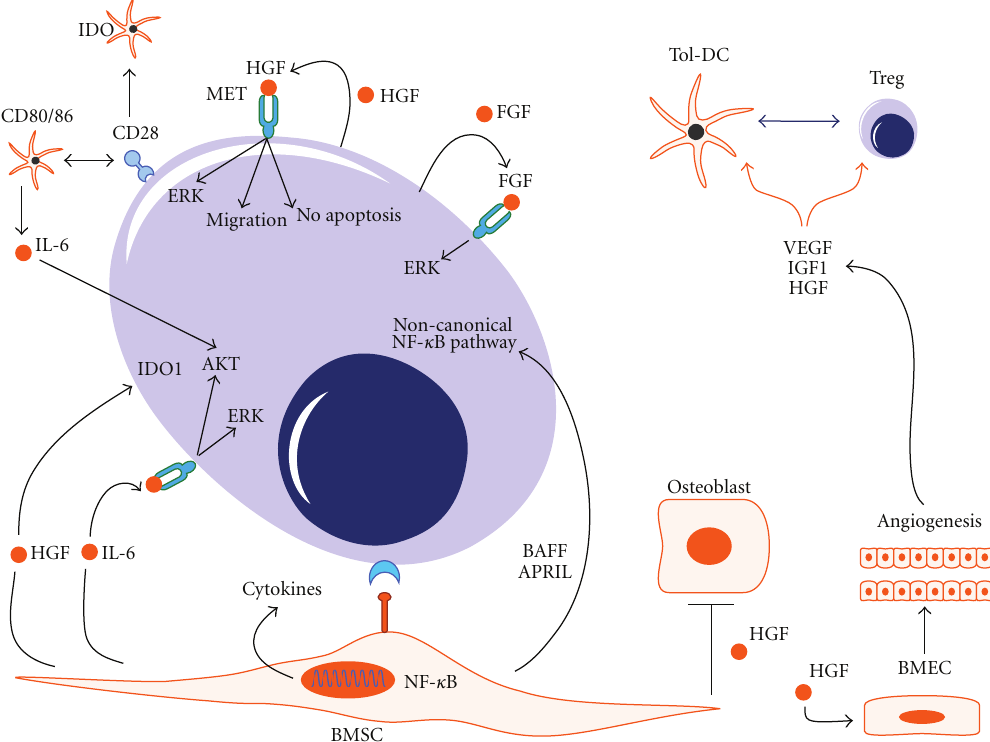
Figure 1: Interactions between myeloma and microenvironmental cell types. It is widely accepted that the BM microenvironment promotes myeloma growth [23]. Several cytokines can be released upon the interaction of MM plasma cells and BM microenvironmental cells, such as BM stromal cells (BMSCs), BM endothelial cells (BMECs), and osteoblasts. Among them, HGF is an attractive target for therapy, given its undisputed role in disease pathogenesis and its potential contribution to the myeloma-induced immune dysfunction through the upregulation of (IDO1) in MM cells. Insulin-like growth factor- (IGF-)1 receptor is also aberrantly expressed by myeloma cells and it has been associated with a poor prognosis [24]. The activation of cytokine networks ultimately leads to the development of immune suppression, through e ff ects on Treg cells and DC. For instance, HGF has been shown to inhibit DC function both in mice and in humans [25, 26], favoring the emergence of tolerogenic DC. The main signaling pathways activated by HGF, IL-6, and other cytokines implicated in MM pathogenesis are